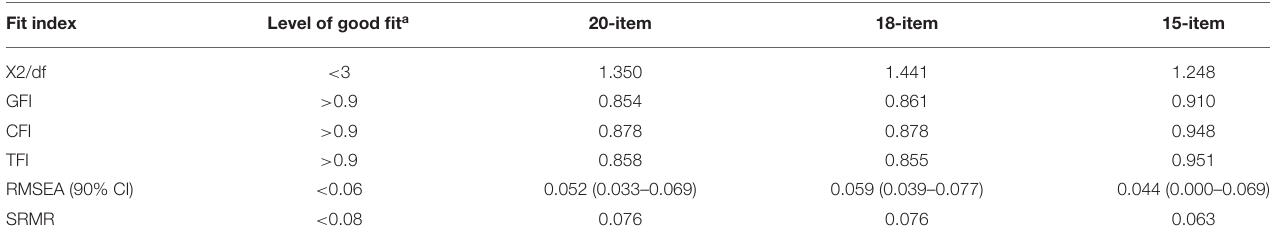
TABLE 3 | CFA fit statiscs for 20-item, 18-item, and 15-item CAPS-5